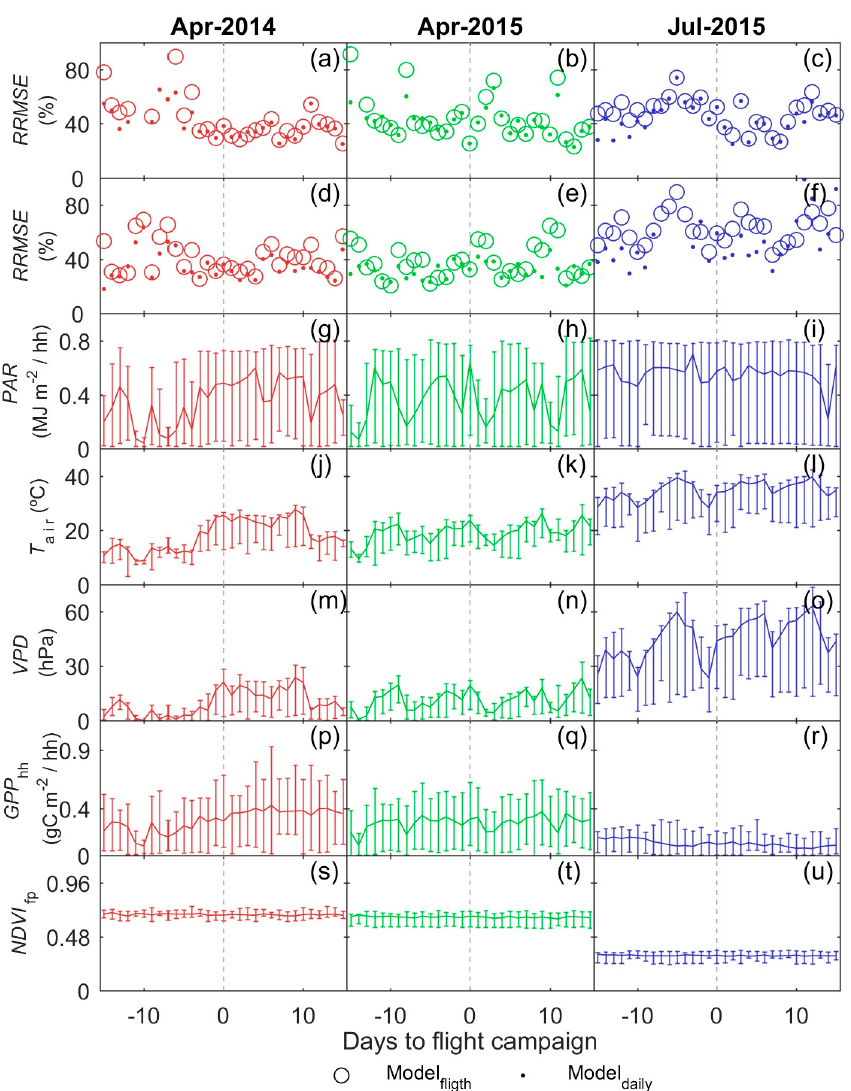
Figure 6. MOD1 RRMSE ( a – c ); and MOD4 RRMSE ( d – e ). Ranges and median values of: PAR ( g – i